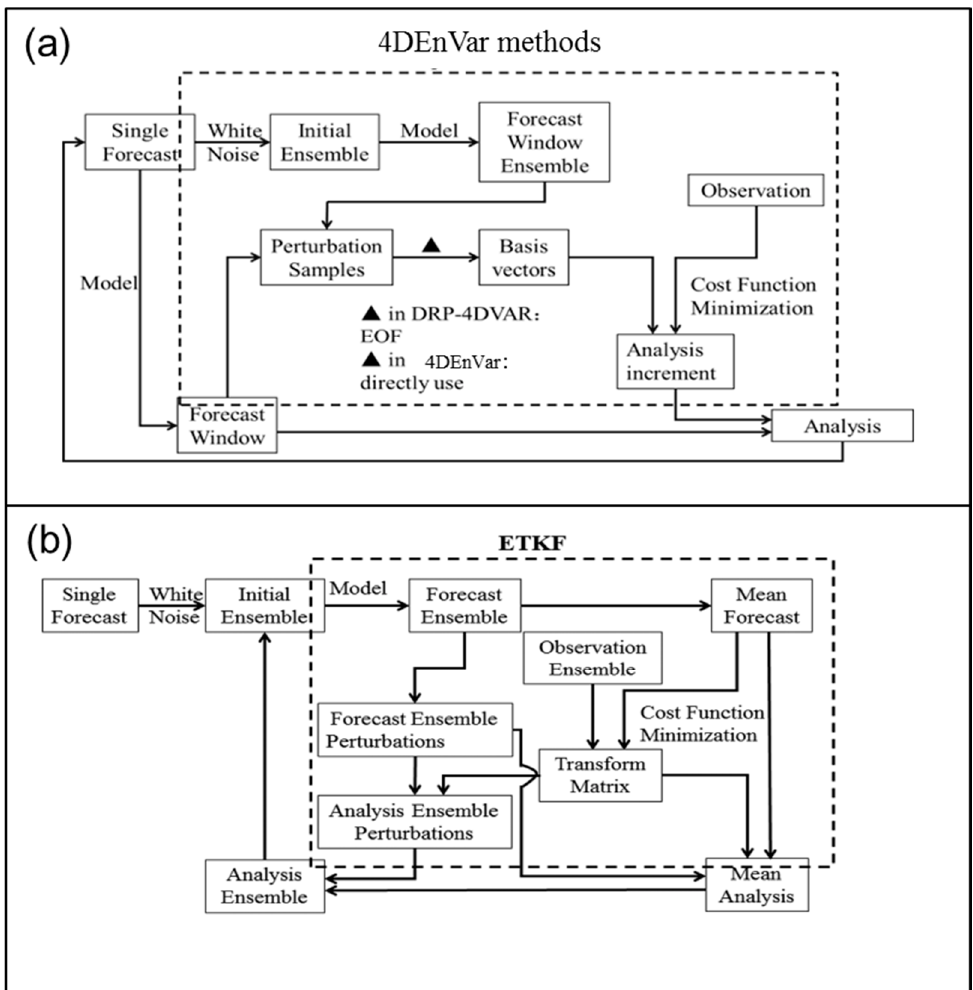
Figure 1. Schematic diagram of the 4DEnVar method ( a ) and the ETKF ( b ).